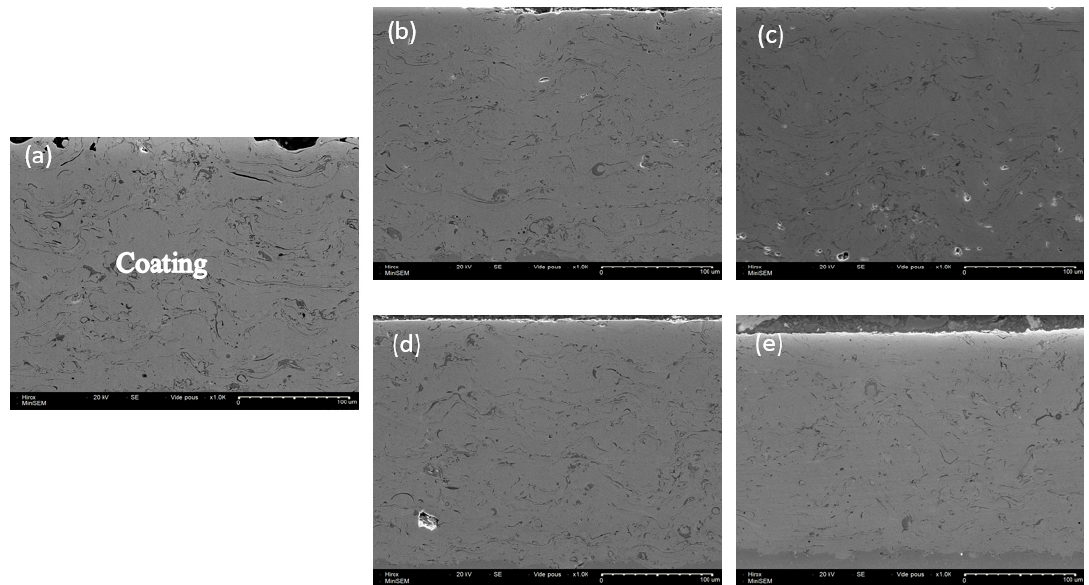
Figure 2. Cross-sectional morphology of 80Ni–20Cr coating: ( a ) Untreated Ni–Cr; ( b ) SMATed with an amplitude of 15 µ m for 405 s; ( c ) SMATed with an amplitude of 15 µ m for 810 s; ( d ) SMATed with an amplitude of 25 µ m for 400 s; ( e ) SMATed with an amplitude of 25 µ m for 800